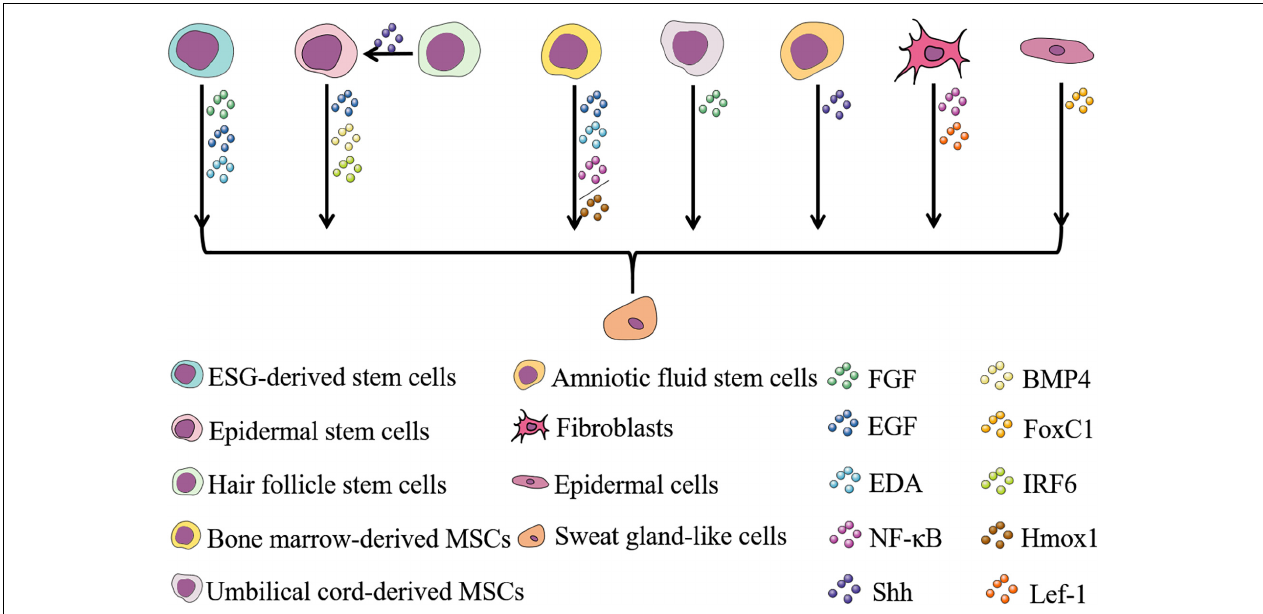
FIGURE 3 | Cells and factors involved in ESG regeneration and their relationships. Stem cells are often used in the study of wound repair and regeneration of various tissues due to their ability to self-renew and differentiate into multiple lineages. To date, eight types of cells have been reported to have the potential to regenerate ESGs (Shikiji et al., 2003; Li et al., 2006, 2015b; Nolte et al., 2008; Sheng et al., 2009; Vierbuchen et al., 2010; Lu et al., 2012; Xu et al., 2012, 2016; Wang et al., 2013, 2019; Hassan et al., 2014; Tao et al., 2014; Liang et al., 2016; Kolakshyapati et al., 2017; Sun et al., 2018; Yao et al., 2018, 2019, 2020; Chen et al., 2019; Hu et al., 2019). Cytokines and growth factors play a role in inducing cells directed to differentiate into sweat gland-like cells during the process of ESG regeneration, and the discovery of these factors involves research on the determination and development of ESGs (Shikiji et al., 2003; Cai et al., 2011; Zhao et al., 2015;